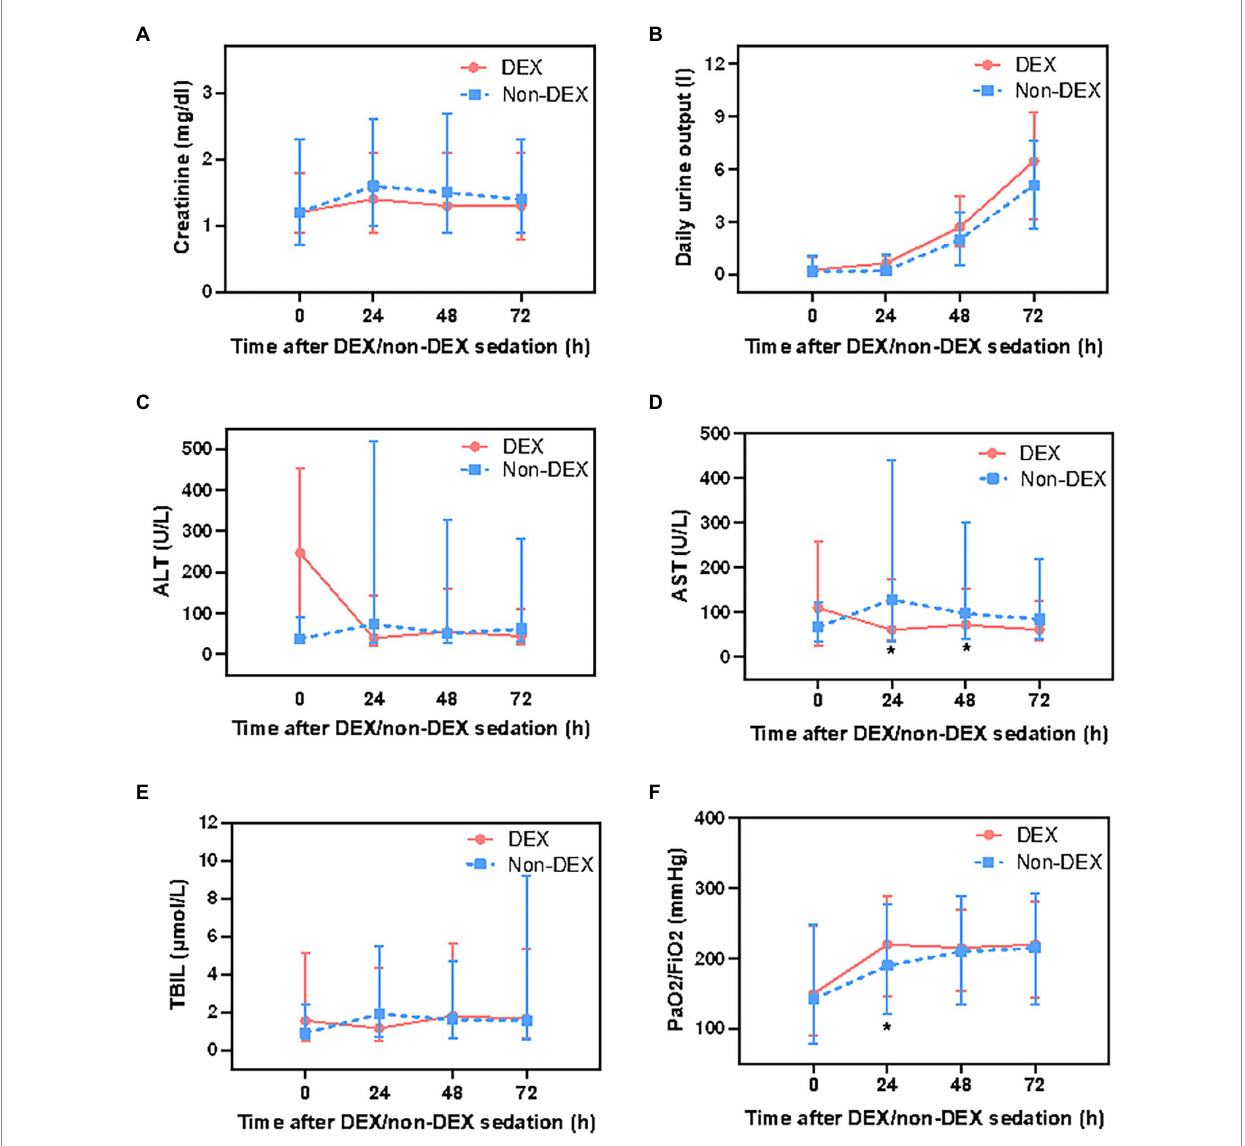
FIGURE 4 The effect of DEX/non-DEX administration on parameters of multiple organ functions in patients with septic shock and mechanical ventilation. (A) Serum creatinine level. (B) Daily urine output. (C) ALT level. (D) AST level. (E) TBIL level. (F) PaO 2 /FiO 2 . *Statistically significant after Bonferroni correction ( p < 0.0125).